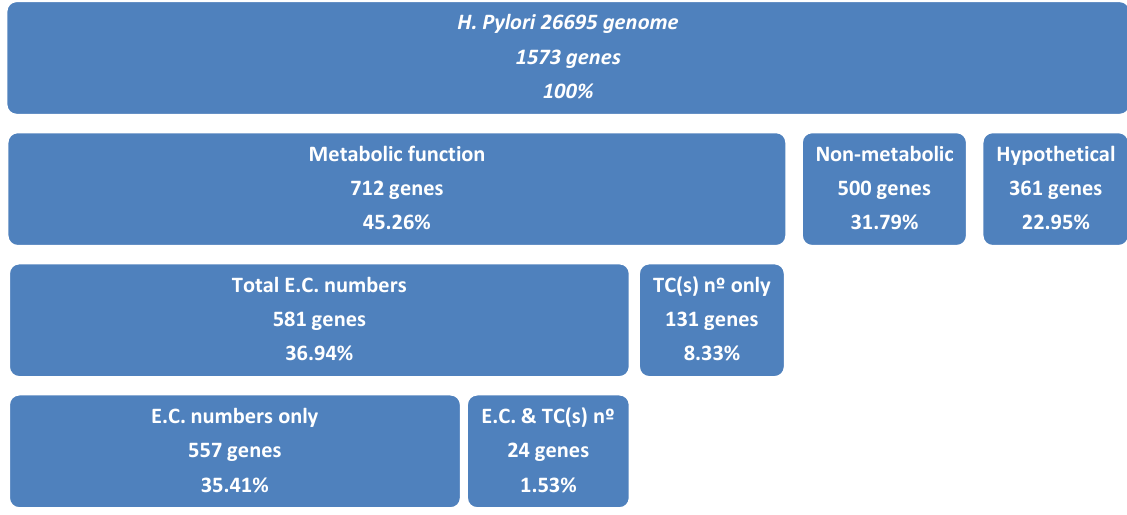
Figure 2: H. Pylori 26695 re-annotation results and statistics